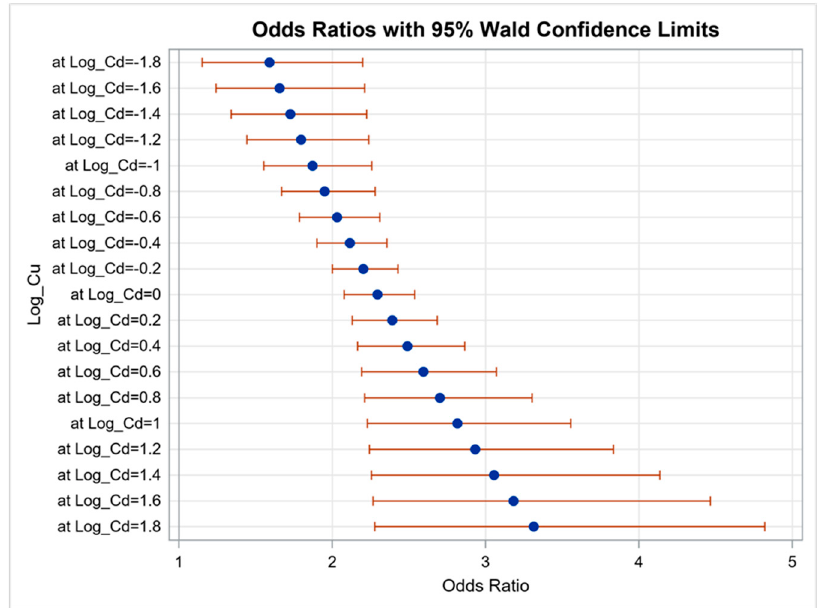
Figure 2. Synergistic effect of urine Cd and Cu on proteinuria. The interaction between urine Cd and Cu on proteinuria was statistically significant ( p = 0.033).